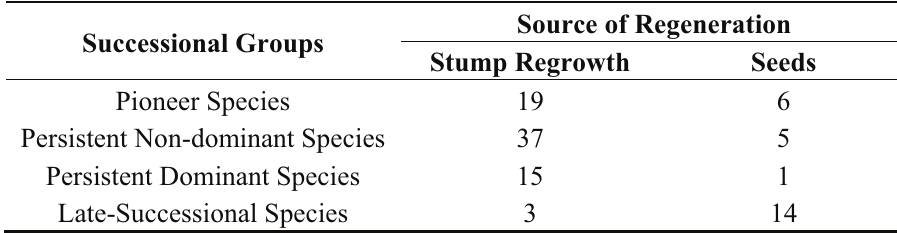
Table 2. Number of species from different successional groups that regenerate from seeds and/or stump regrowth (data from the current